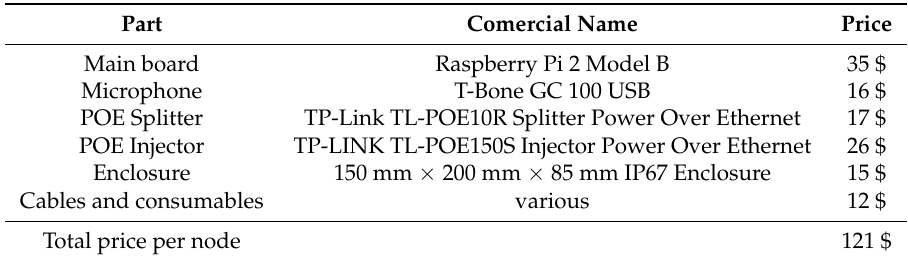
Table 1. List of the components used in the final